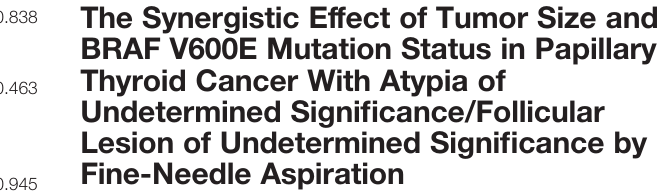
respectively. The rates of BRAF V600E mutation for PTMC and PTC were 64.6% (153/237) and 64.0% (32/50), respectively ( Table 2 ). The rates of extra-thyroid extension were 46.2% (24/ 52) and 19.8% (47/237) for PTC and PTMC, respectively (p < 0.001). Compared with PTMC, PTC had higher crude ORs of